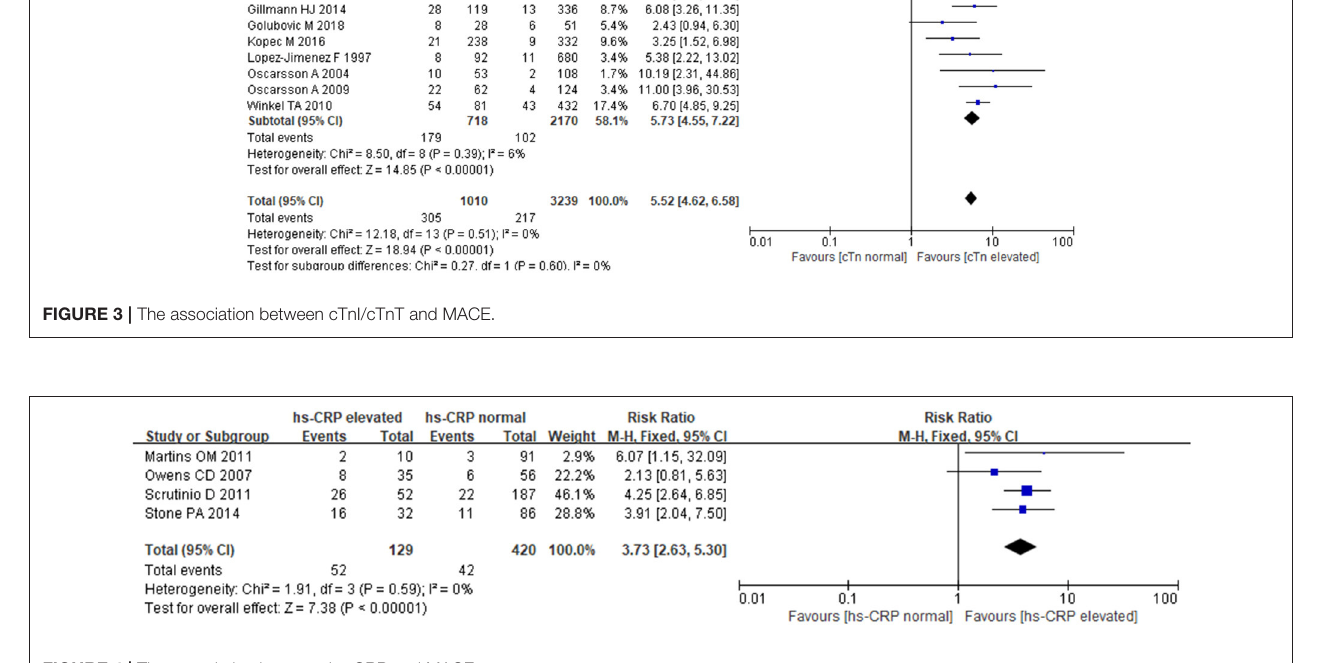
Frontiers in Physiology | www.frontiersin.org